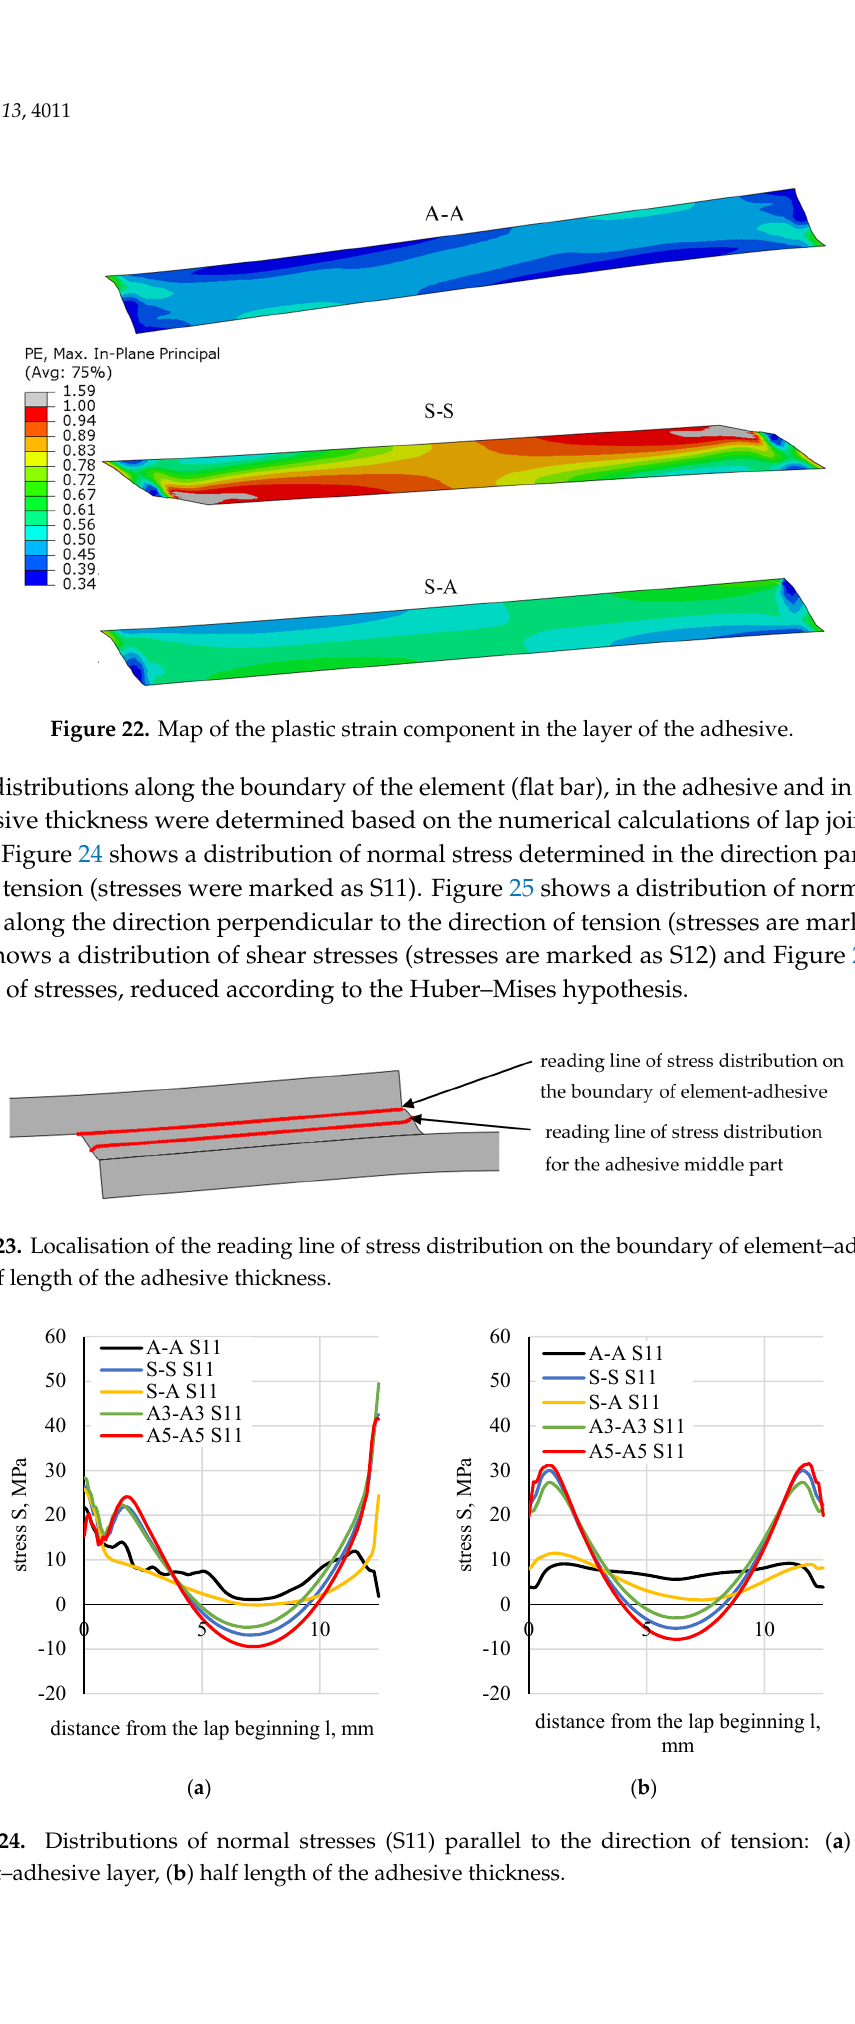
( b ) Figure 25. Distributions of normal stresses (S22) perpendicular to the direction of tension: ( a ) in the boundary element–adhesive layer, ( b ) half length of the adhesive thickness.